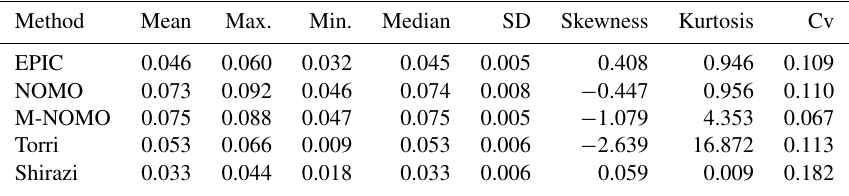
Table 2. Statistics of soil erodibility in the Ansai watershed. Method Mean Max. Min. Median SD Skewness Kurtosis Cv EPIC 0.046 0.060 0.032 0.045 0.005 0.408 0.946 NOMO 0.073 0.092 0.046